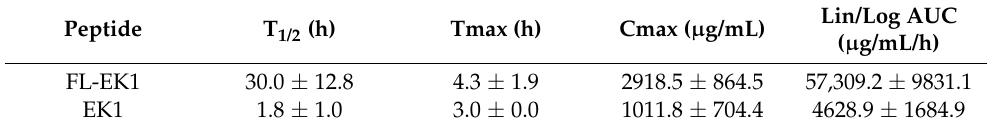
Table 2. Pharmacokinetic parameters of FL-EK1 and EK1 by intraperitoneal injection in mice. Peptide T 1/2